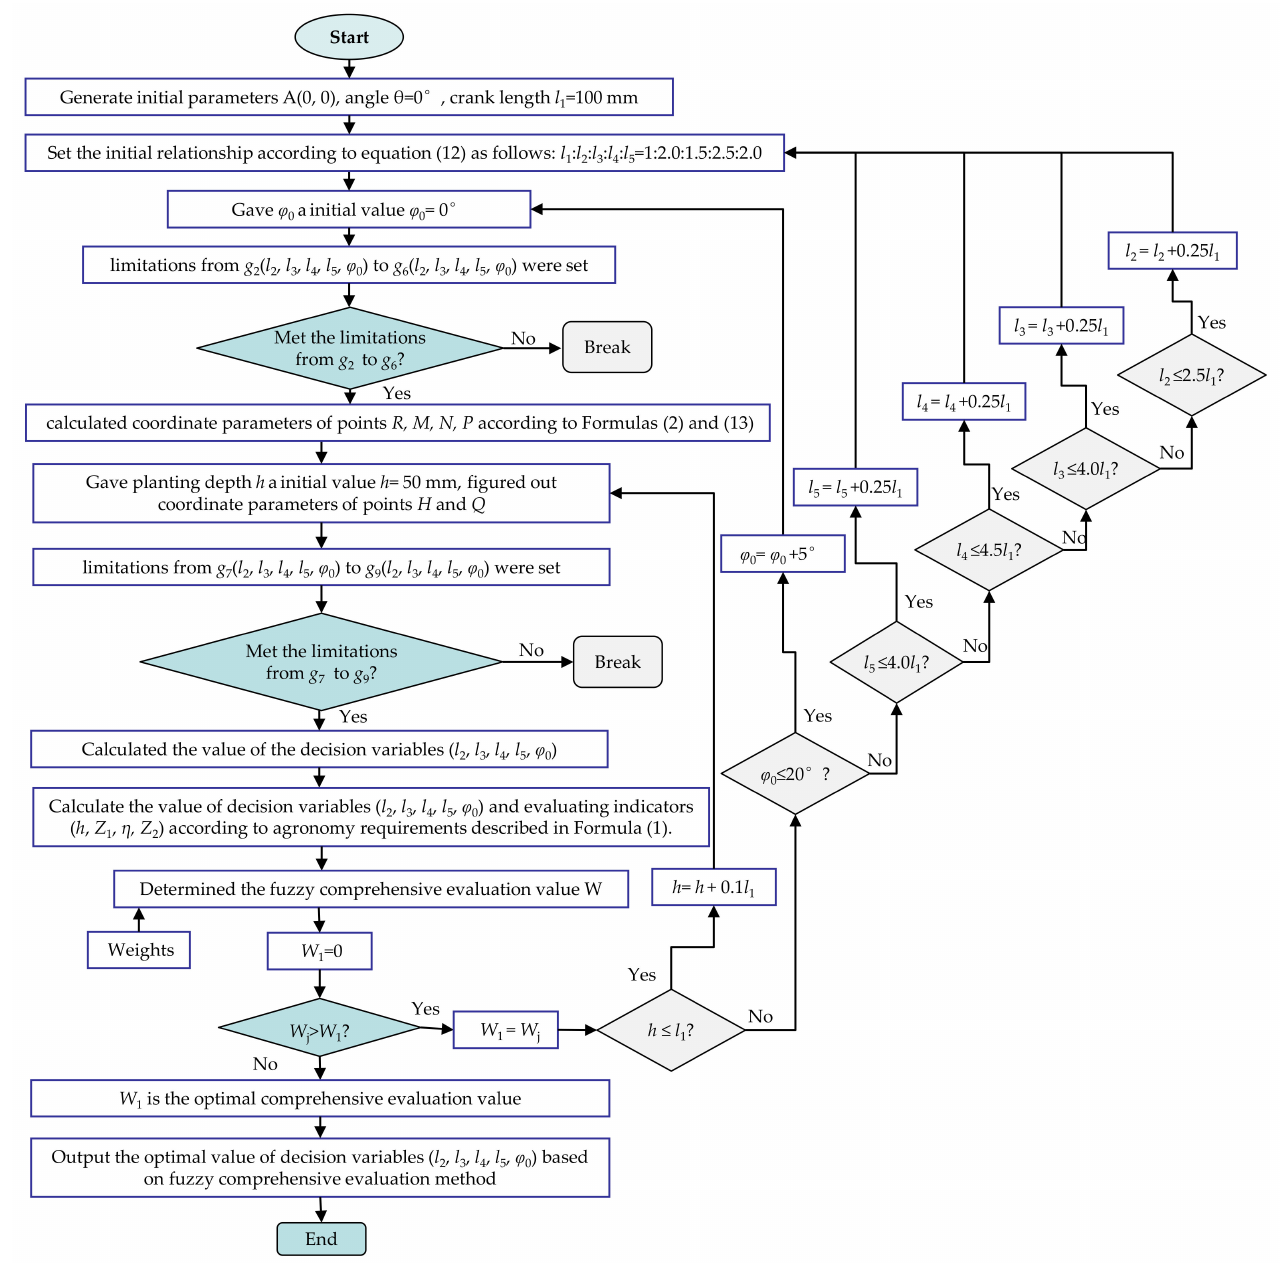
Figure 7. Optimal solution method for decision